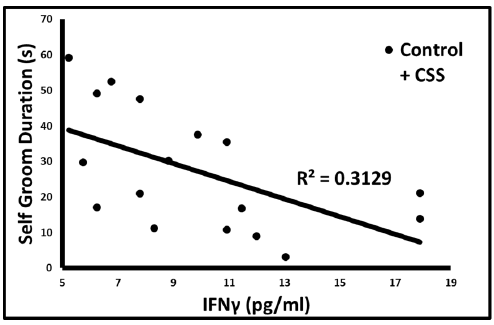
Figure 3. Correlation between IFN and self grooming duration in both groups combined.